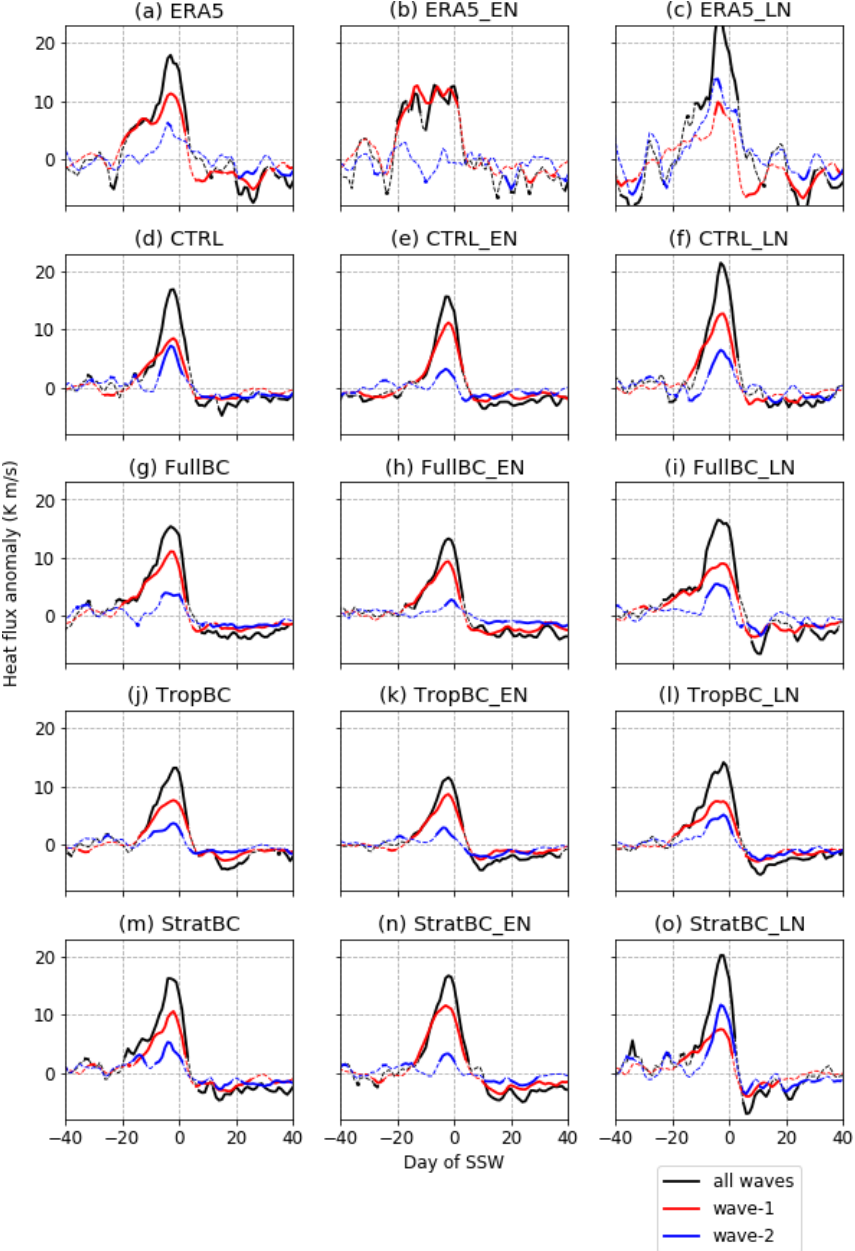
Figure 9. Heat flux anomaly at 100hPa, 45–75 ◦ N for SSW events composited on day zero of SSWs, defined for wave 1 (red), wave 2 (blue), and all waves (black). In model experiments, the anomalies are calculated with respect to that experiment’s climatology. In ERA5, the anomalies for all years as well as for ENSO years are calculated with respect to the ERA5 climatology. ERA5 data from 1979–2019, 100 years for each model run (neutral, El Niño, and La